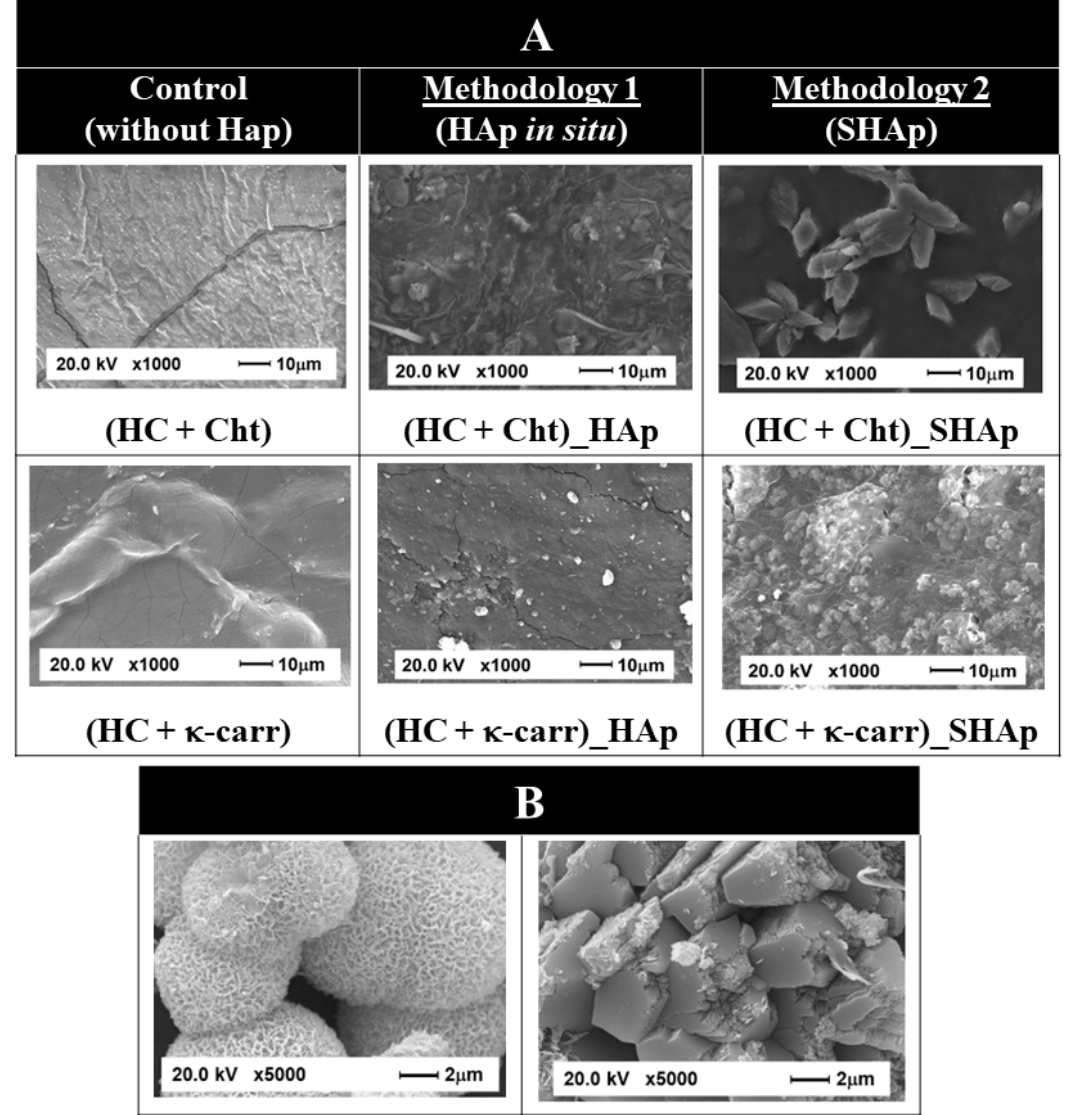
Figure 2. Morphological characterization of the membranes. ( A ) SEM images of biopolymeric membranes before (control) and after incorporation of the mineral by Methodology 1 or 2. ( B ) SEM images of SHAp showing different morphologies that can be assigned to the formed HAp (needle ‐ like) and brushite (plate ‐ like).